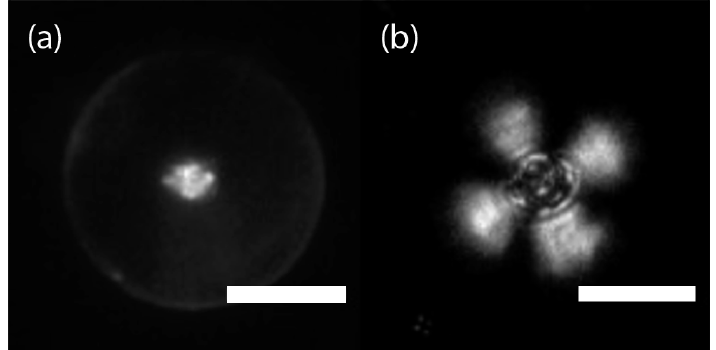
Figure 3 . Quantum dot cluster imaged using ( a ) fluorescence microscopy and ( b ) cross-polarized bright field microscopy at the center of a droplet designed to exhibit the bipolar defect configuration. After cooling to the nematic phase, particles were found to be located at a single central point in the radial defect configuration. Scale bars = 20 μ m.